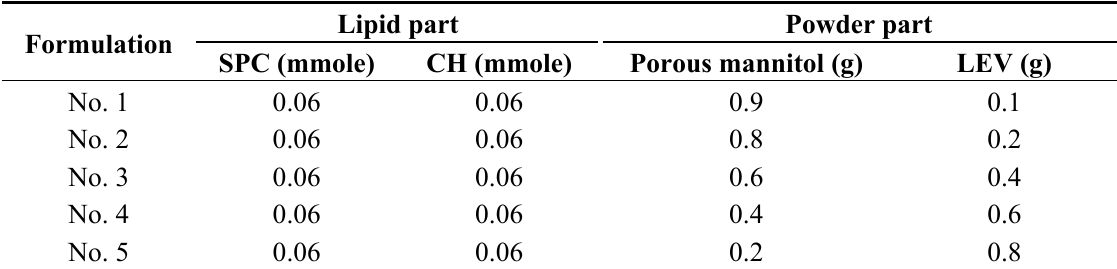
Table 5. Formulation ingredients for